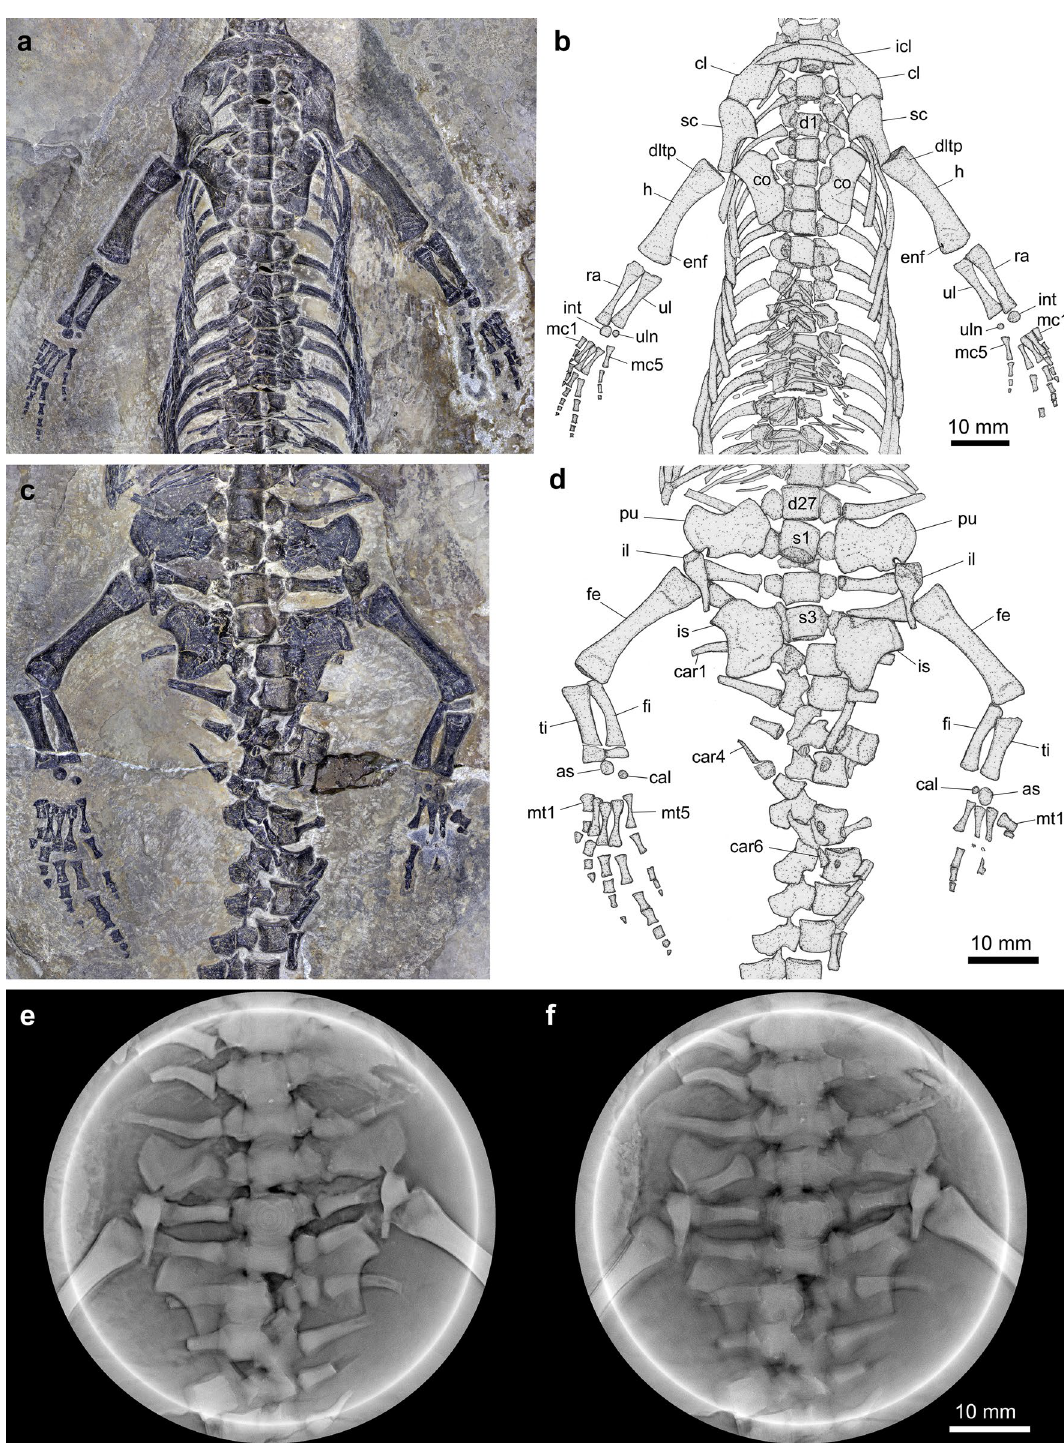
Figure 4. Girdles, limbs and vertebrae of Luopingosaurus imparilis gen. et sp. nov., IVPP V19049. Photo ( a ) and line-drawing ( b ) of pectoral girdle, forelimbs and anterior dorsal vertebrae. Photo ( c ), line-drawing ( d ) and two computed laminography scanning slices ( e , f ) of pelvic girdle, hind limbs and posterior vertebrae. as, astragalus; ca, caudal vertebra; cal, calcaneum; car, caudal rib; co, coracoid; d, dorsal vertebra; dltp, deltopectoral crest; enf, entepicondylar foramen; fe, femur; fi, fibula; h, humerus; il, ilium; int, intermedium; is, ischium; mc, metacarpal; mt, metatarsal; pu, pubis; s, sacral vertebra; sc, scapula; sr, sacral rib; ti, tibia; ul, ulna; uln,